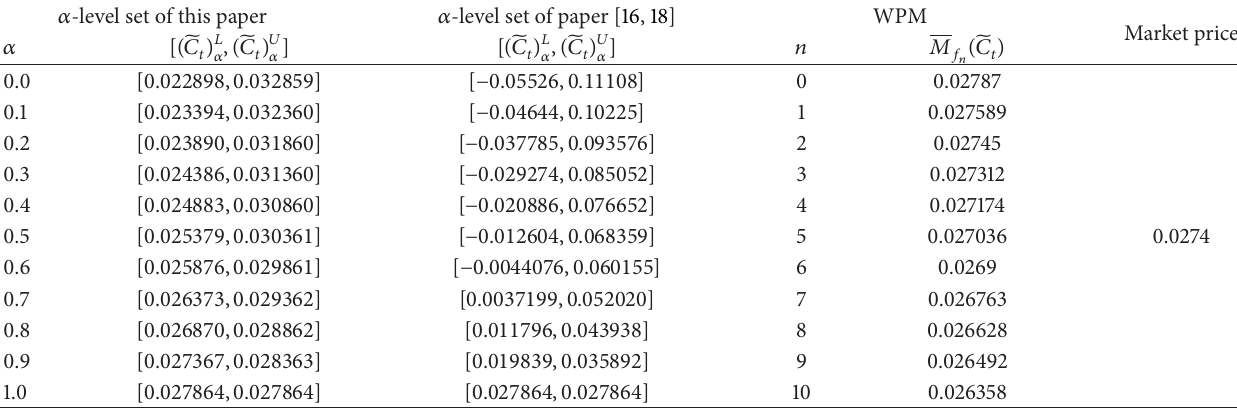
Table 1: Fuzzy EUR/USD currency option